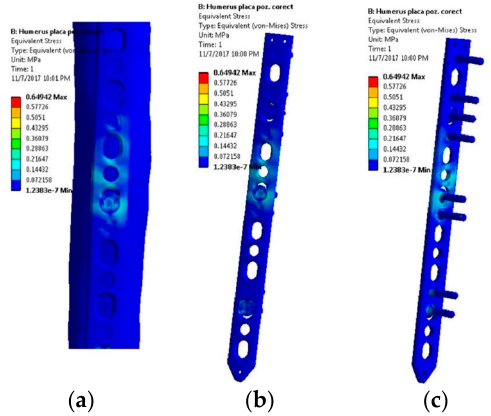
Figure 9. Stress distribution within the LCP when a 5 Nm torque is applied—rotation movement tendency: